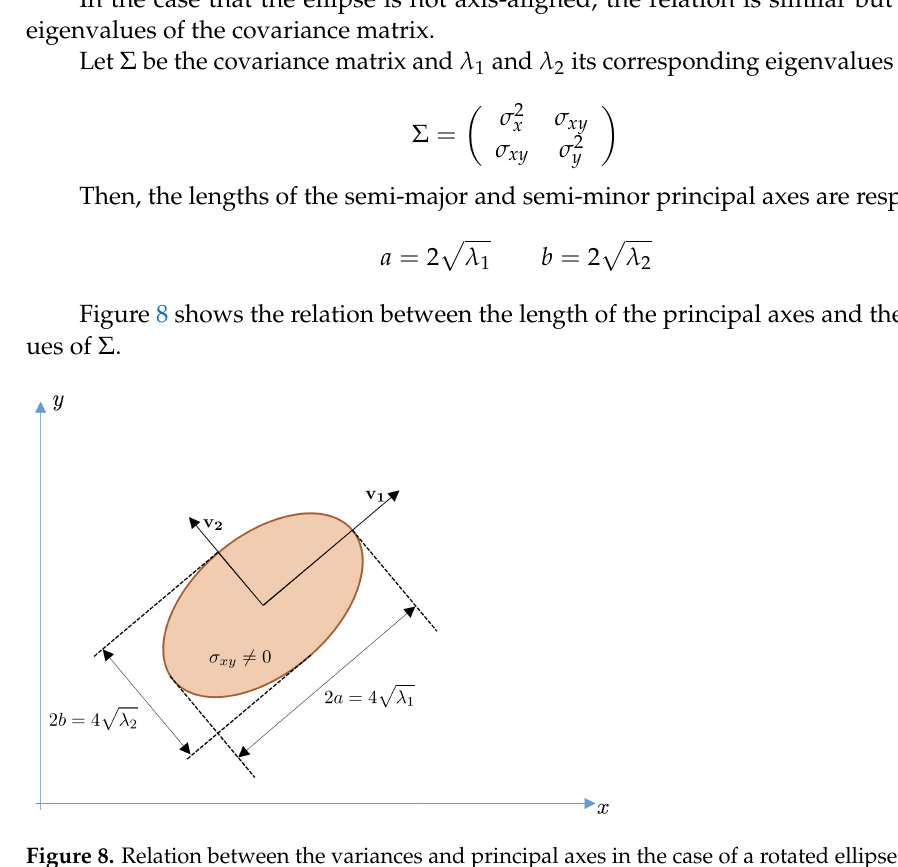
Figure 8. Relation between the variances and principal axes in the case of a rotated ellipse. λ 1 and λ 2 are the eigenvalues of the covariance